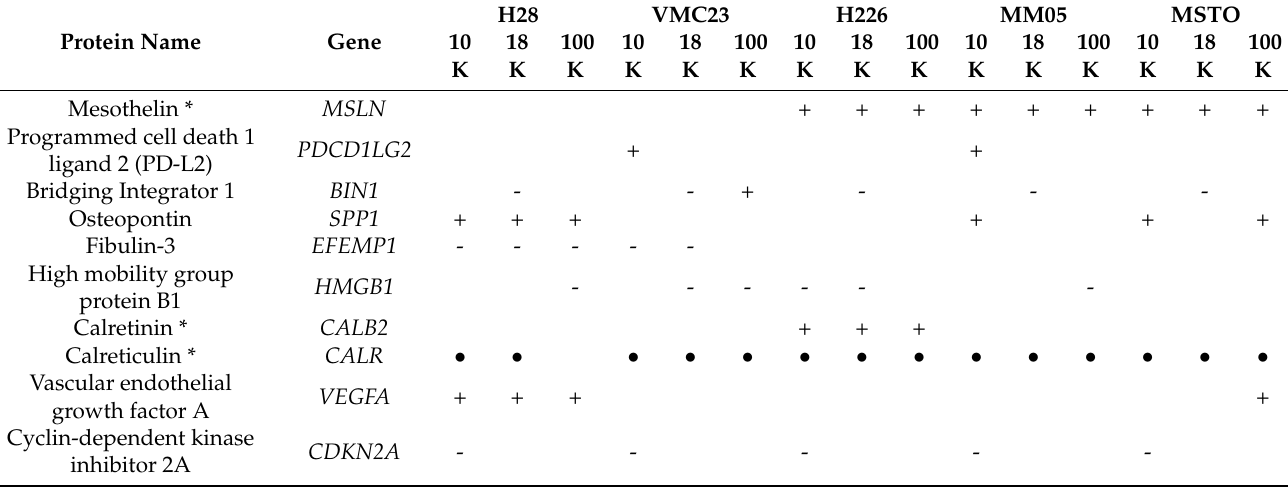
Table 10. Expression of biomarkers known to have biomarker potential in pleural